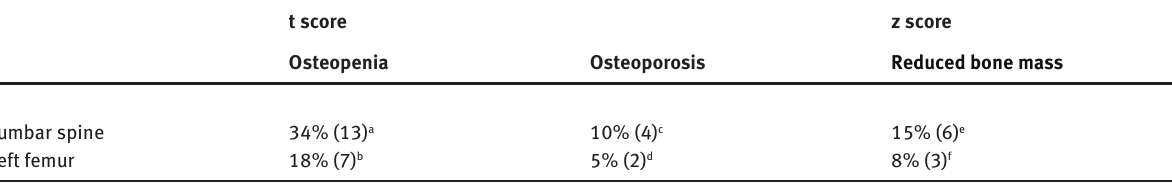
Table 4. Frequency of osteopenia, osteoporosis and reduced bone mass in patients with early